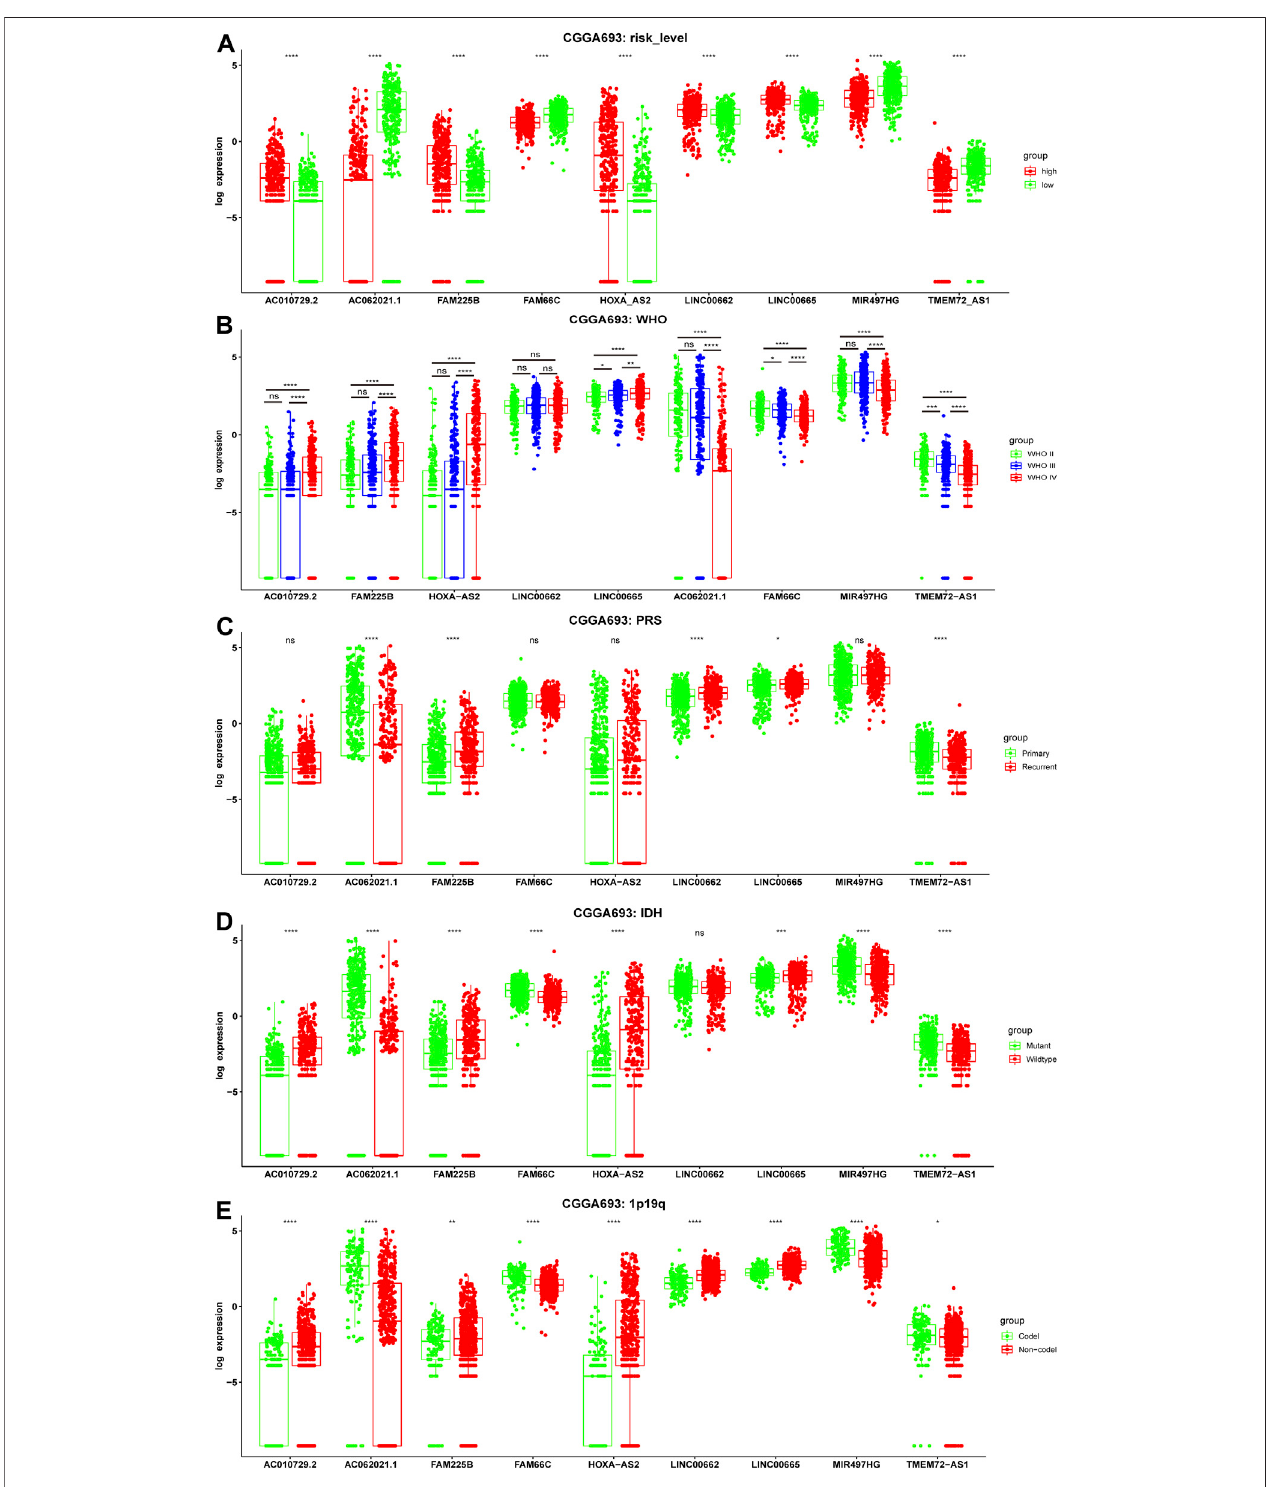
FIGURE 5 | Correlation between the expression level of nine ferroptosis-related lncRNAs and clinicopathological features in the training CGGA693 cohort. (A – E) Risk level, WHOgrade,PRStype,IDHmutationstatus,and1p19qcodeletionstatus.WHO:WorldHealthOrganization;P:Primary,R:Recurrent,S:SecondaryRecurrent;ns:Notsigni fi cant, * p < 0.05, ** p < 0.01, *** p < 0.001.